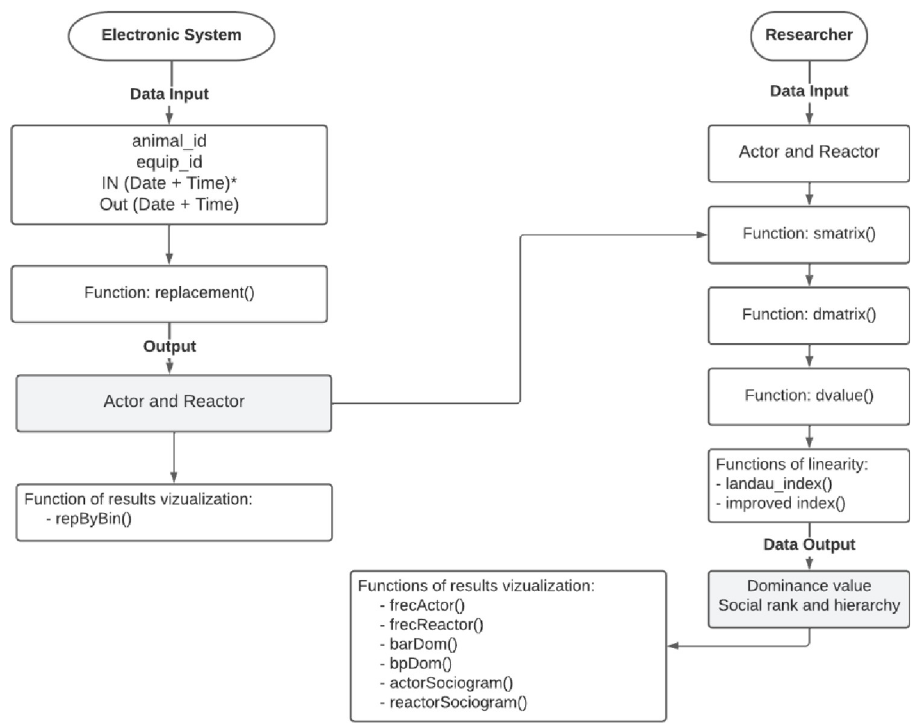
Fig 1. R package flow chart for competition behaviour analysis. � Format of datasheet: date—dd/mm/yyyy; time— hour:minutes:seconds.